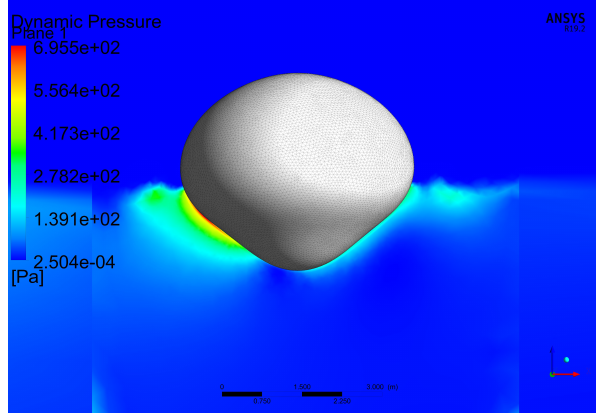
Figure 16. Dynamic pressure field measured around the device at t = 1.5 s.